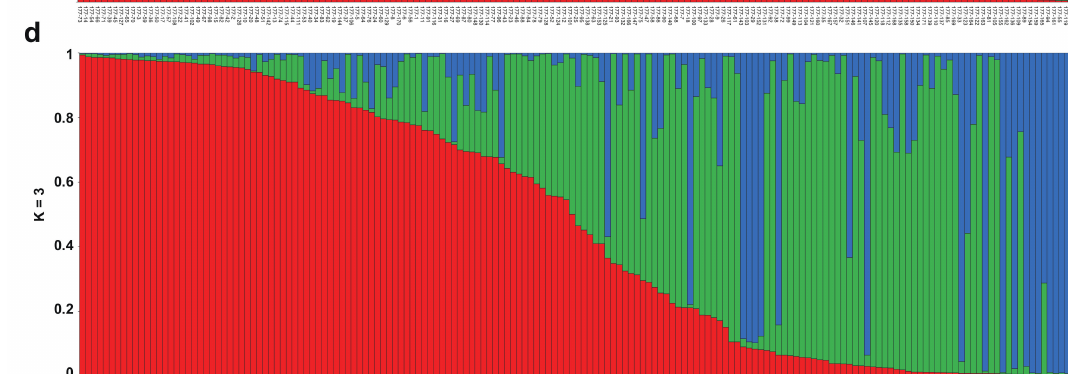
Figure 2. Population structure of 171 turnip varieties based on SSR analysis. Codes (177-01~177-171) for varieties found in Ta- ble S1. ( a ) Estimation of the optimum number of groups (K). The sharp peak of ∆ K at K = 2 suggests two subpopulations. ( b ) Graph for the parameter LnP (D) and each value of (K). ( c ) Population structure when K = 2. ( d ) Population structure when K = 3. The proportion of each color indicates the probability of each variety being divided into the corresponding